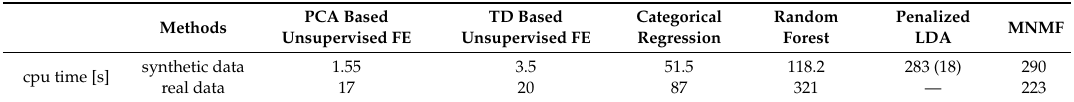
Table 6. CPU times of the six methods required for the synthetic and real datasets. The CPU time for PenalizedLDA is for testing four λ values with between one and eight discriminant functions. The CPU time for an individual run is 18 s. Cpu times for synthetic data were averaged over 100 independent